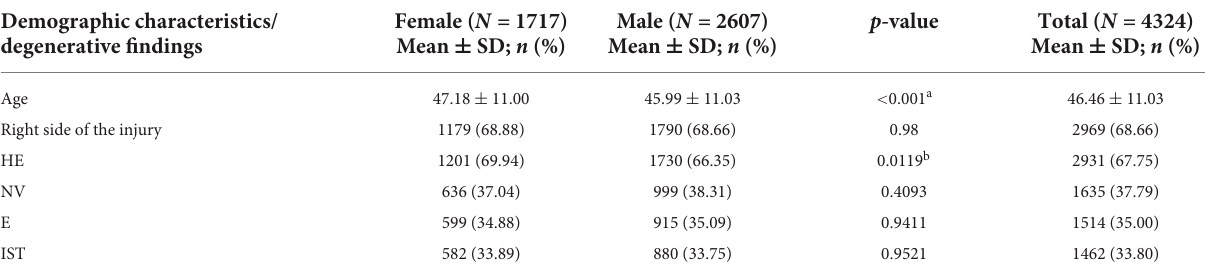
TABLE 1 Ultrasound findings comparison between